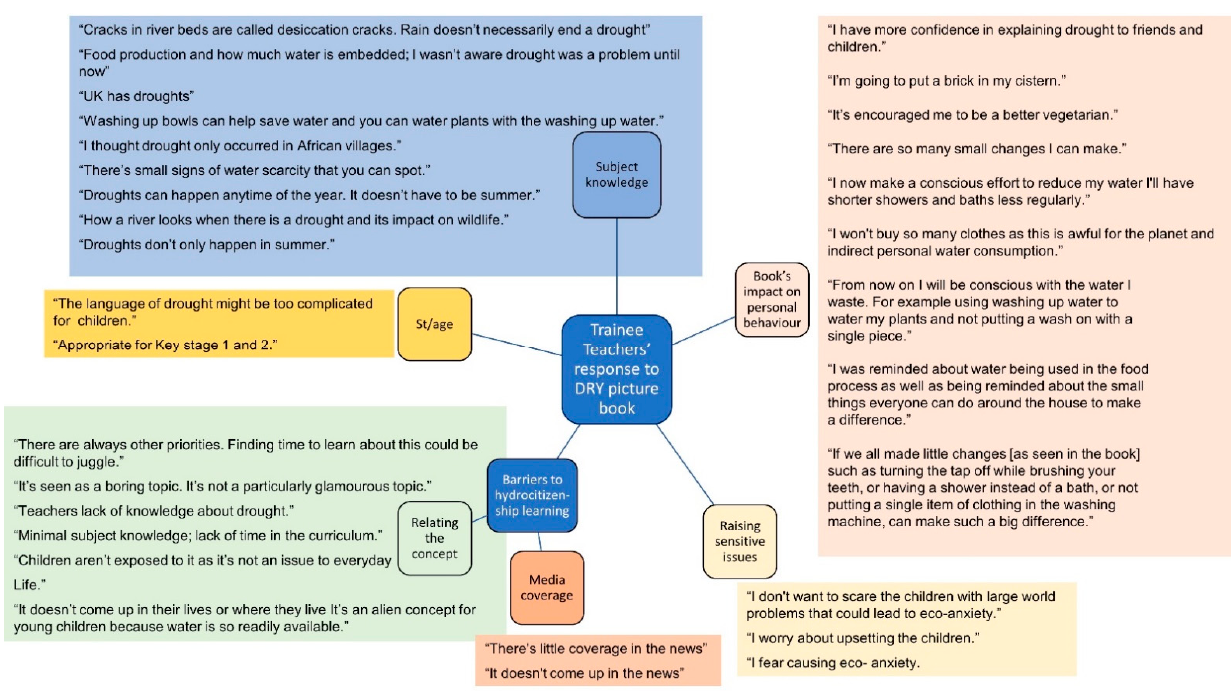
Figure 2. Young people responses to the DRY picture book.